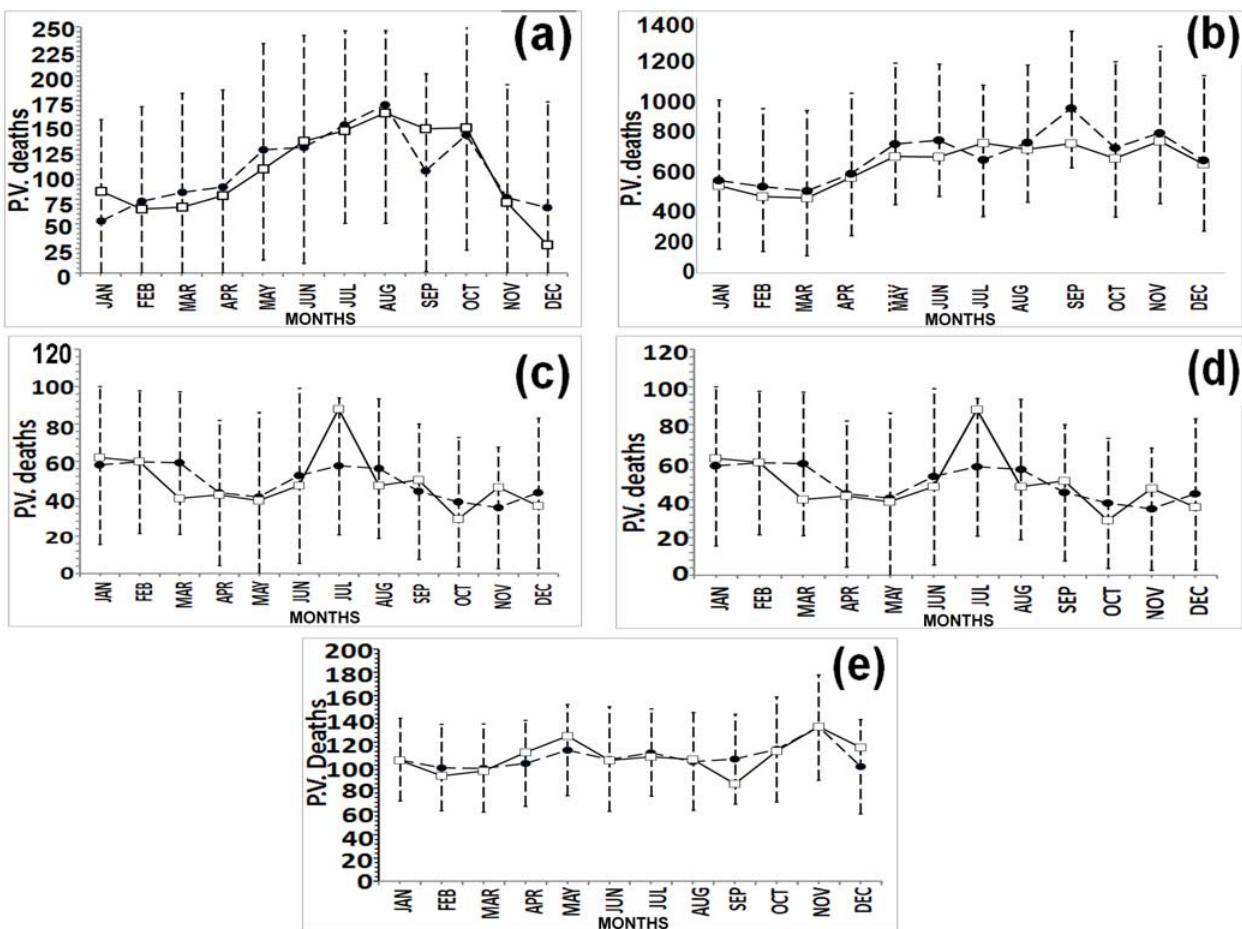
Figure 6. Plot of fits of predictions based on the proposed model against the observed values for 5 clusters. (a) cluster I, (b) cluster II, (c) cluster III, (d) cluster IV, (e) cluster V (Straight line with white squares-observed P.vivax Deaths; Dashed line with black circles-predicted values of P.vivax Deaths from the model). Error bars are of 95% confidence intervals of the predicted response.